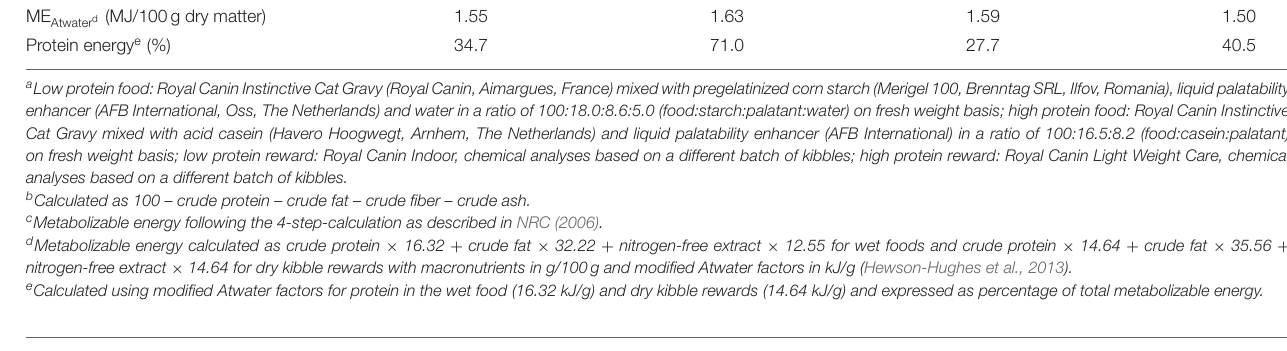
Dry matter (as is) Crude protein Crude fat Crude